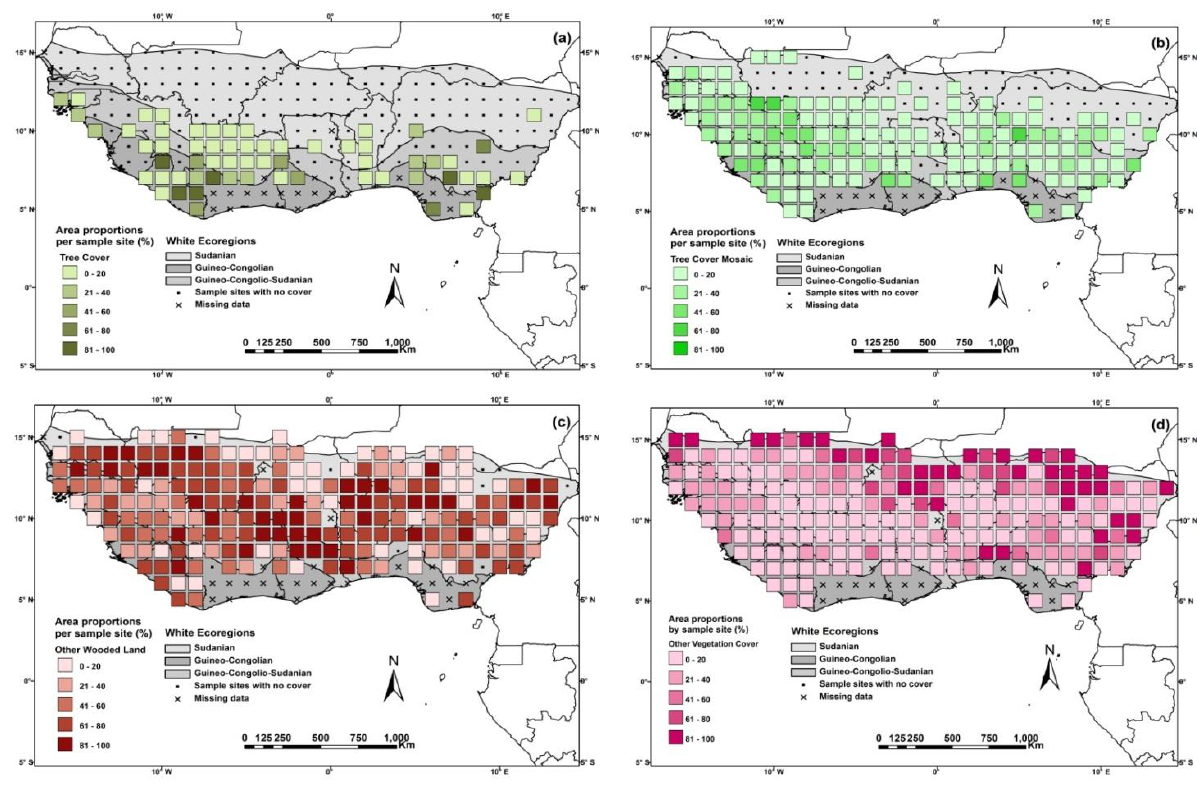
Figure 7. Area proportions of land cover classes for each sample site ( n = 220) for the